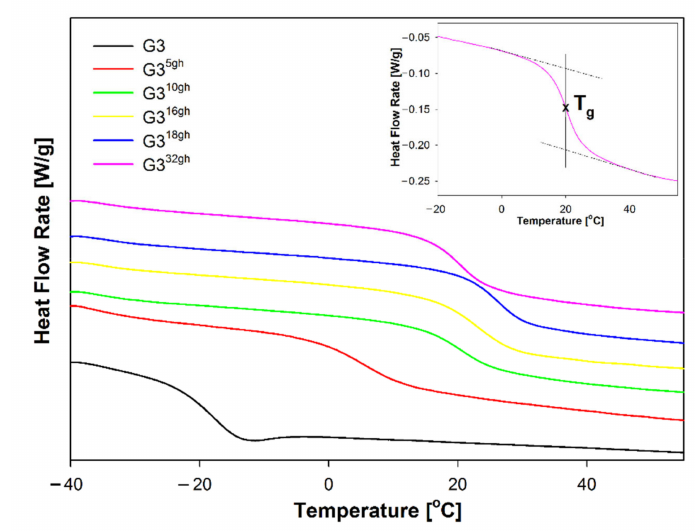
Figure 7. Comparison of heat-flow rates of G3 gh conjugates versus temperature: The scheme of glass transition estimation was shown based on G3 32gh data in the inset in the upper right corner.